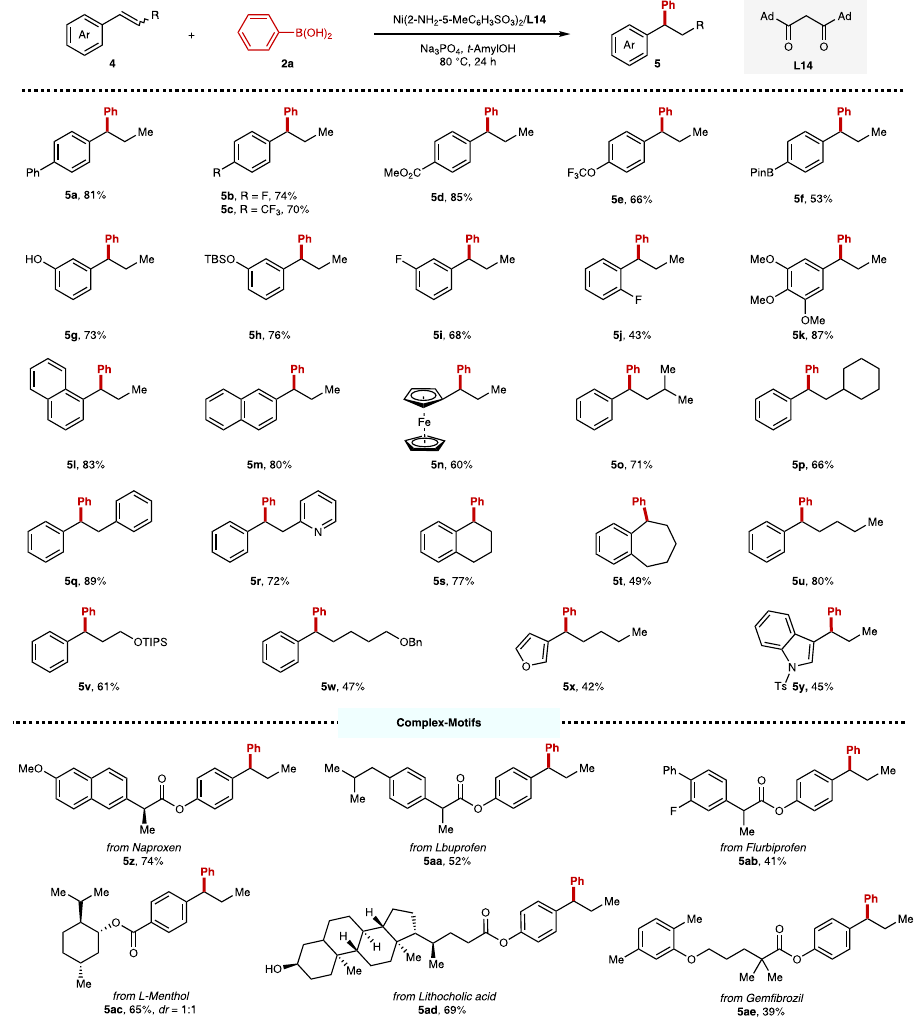
Fig. 4 | The scope of internal alkenes. The values under each structure indicate isolated yields. The regioselectivity was determined by analysis of the crude 1 H NMR (rr>99/1 for all substrates) and the dr was determined by GC. Reaction conditions: 4 (0.2mmol, 1.0 equiv), 2a (0.6mmol, 3.0 equiv), Ni(2-NH 2